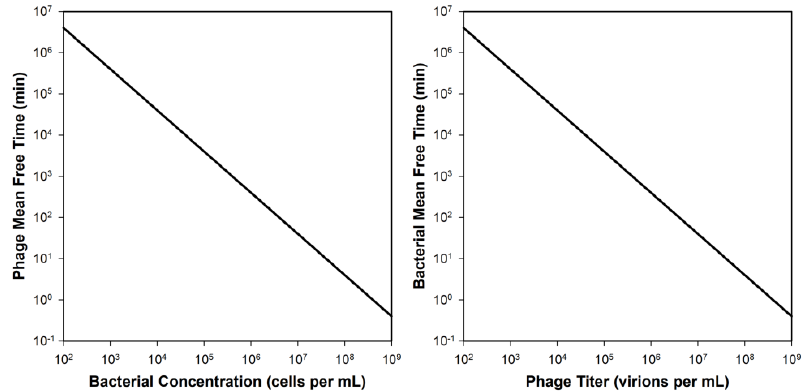
Figure A1. Mean free times (average time until adsorption) as a function of bacterial (left) or phage (right) concentrations ( N and P , respectively). The adsorption rate constant ( k ) is defined here as equal to 2.5 × 10 −9 mL −1 min −1 from Stent [8] and mean free times are defined as 1/ kN [124] , i.e., “on average, the time spent finding a host”, p. 547 [125], or 1/ kP , respectively. These numbers also approximate the time